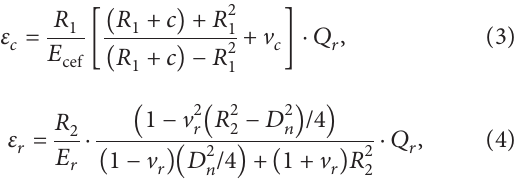
Figure 5: Double-fold line damage constitutive relation, where f is the tensile strength, f tr is the residual tensile strength, ε principal tensile strain corresponding to f t , ε r is the residual strain corresponding to the tensile residual strength f tr , and ε u is the ultimate tensile